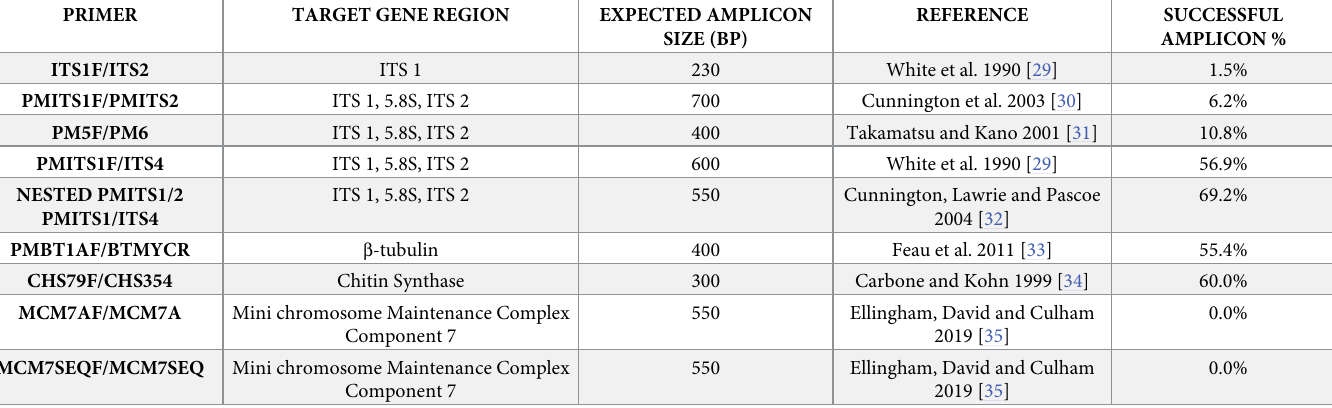
Table 3. Published primer sets tested on all DNA extracted from five VPRI P . leucotricha specimens from 1992–1994 (total = 65 reactions per extraction method), and the percentage of P . leucotricha amplicons generated per primer